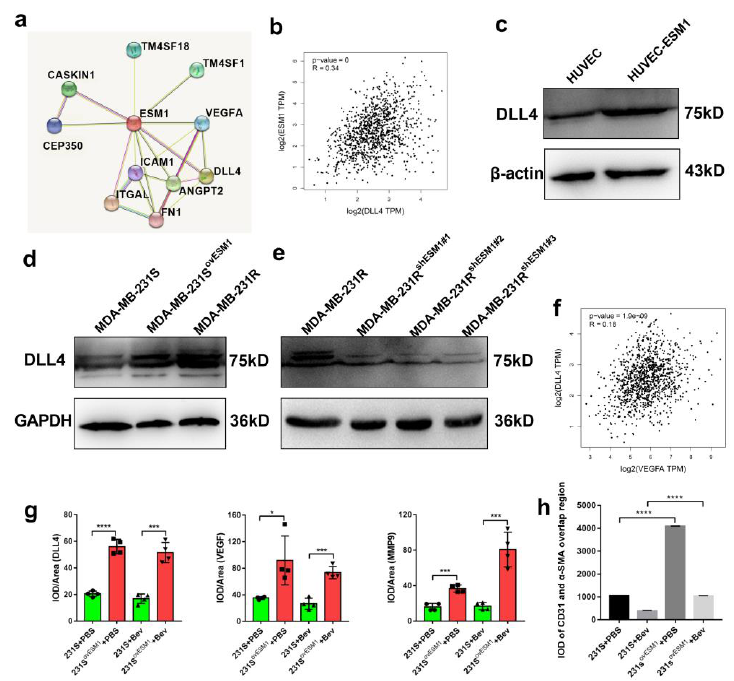
Figure 6. Overexpression of ESM1 increased the expression of DLL4 and promoted productive angiogenesis. ( a ) The protein interaction network was associated with ESM1 in the String Database. ( b ) Gene expression correlation between DLL4 and ESM1 in breast cancer was found in the TCGA database. ( c ) Western blotting for DLL4 in HUVEC cells with or without human ESM1 added (Figure S3). ( d , e ) Western blotting for DLL4 in MDA − MB − 231 − S, MDA − MB − 231 − S ovESM1 , MDA − MB − 231 − R, or MDA − MB − 231 − R shESM1#1 −3 (Figure S4 and Figure S5). ( f ) Gene expression correlation between VEGFA and ESM1 in breast cancer was found in TCGA database. ( g ) Quantitative evaluation of DLL4, VEGFA, and MMP9 in MDA − MB − 231 − S or MDA − MB − 231 − S ovESM1 tumor sections from mice treated with PBS or bevacizumab. * p < 0.05; *** p < 0.001 by t test. ( h ) IOD of CD31 and α− SMA overlap region in MDA − MB − 231 − S or MDA − MB − 231 − S ovESM1 tumor sections from mice treated with PBS or bevacizumab. **** p < 0.0001 by t test.